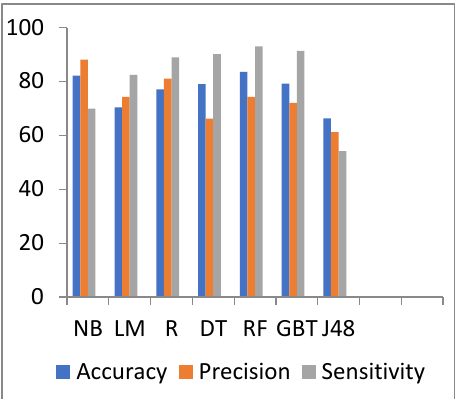
Figure 8. Accuracy, precision, and sensitivity comparison of different algorithms on general health preprocessed data.